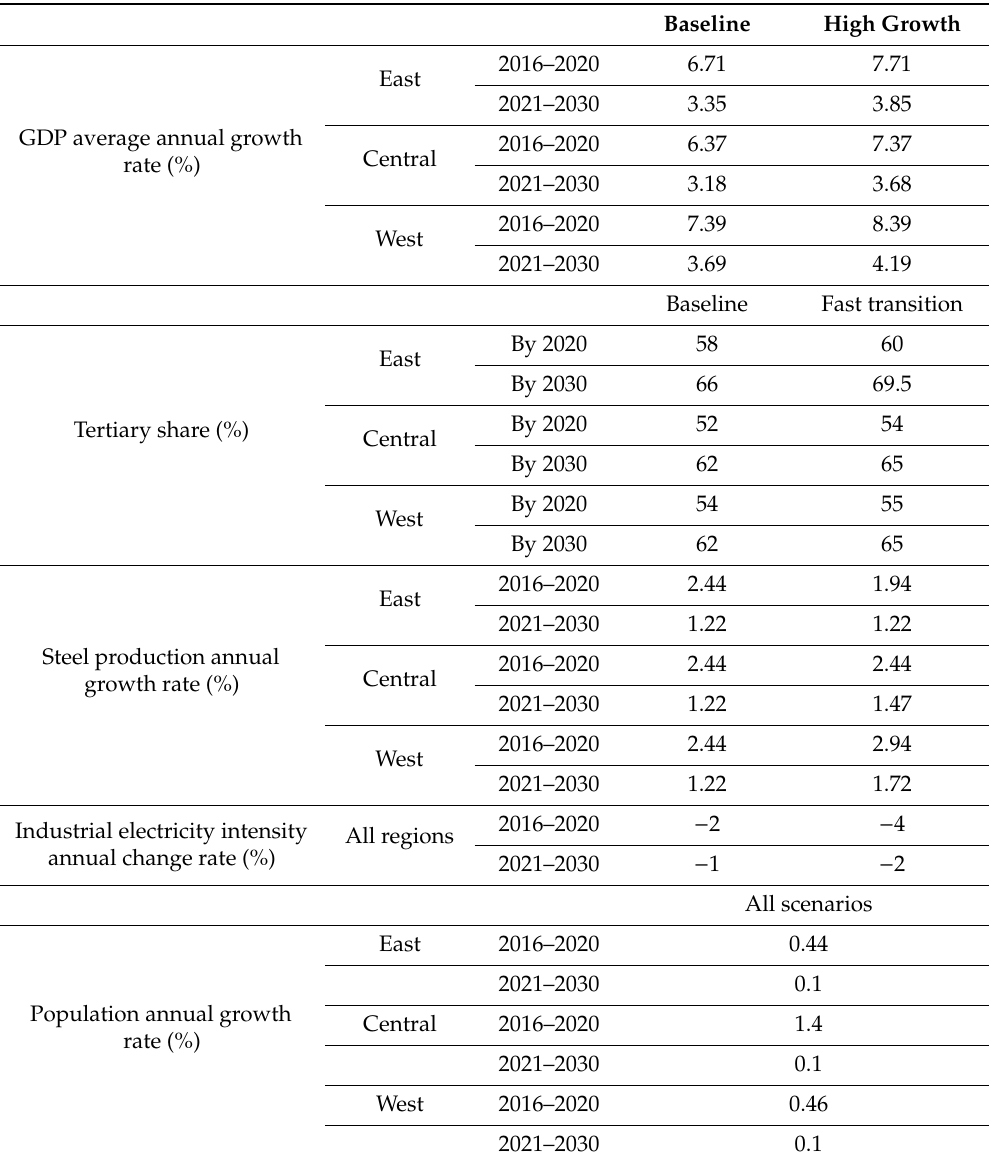
Table 8. Specific assumpsions of key variables under di ff erent